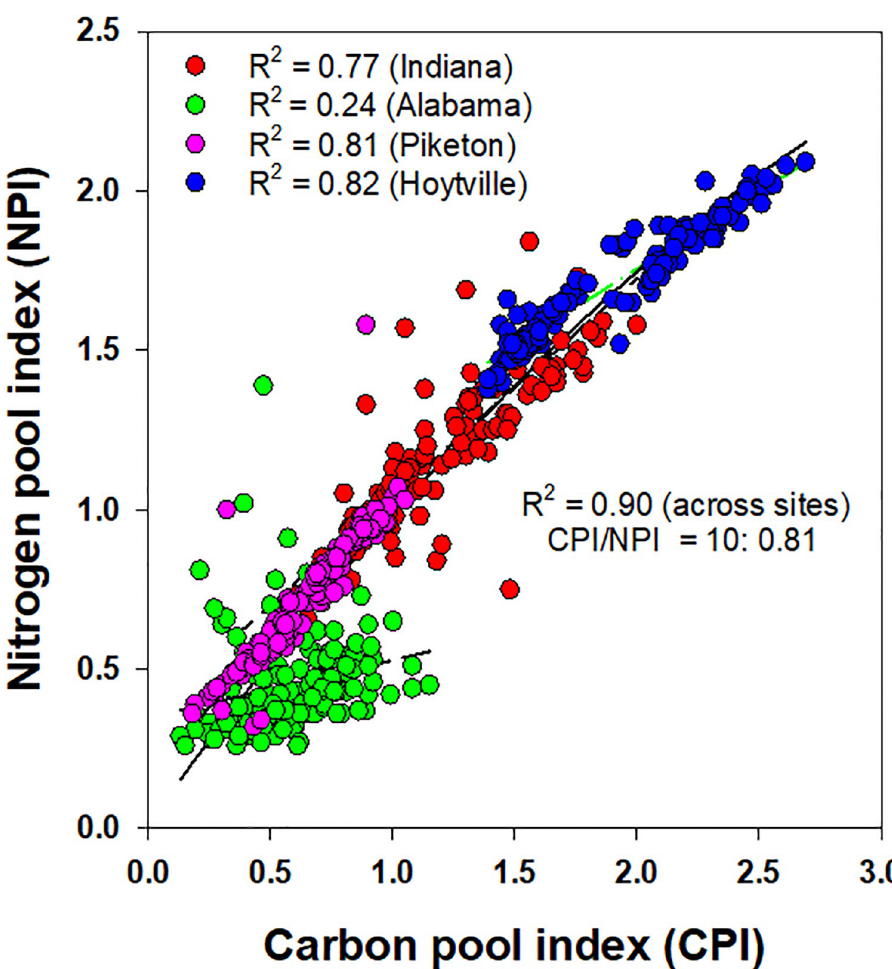
Fig 3. Relationship between soil carbon and nitrogen pool indices for a gypsum-amended rainfed transitional no- till soybean-corn rotation with cover crop in Alabama (Shorter), Indiana (Farmland), and Ohio (Hoytville and Piketon) and averaged across all